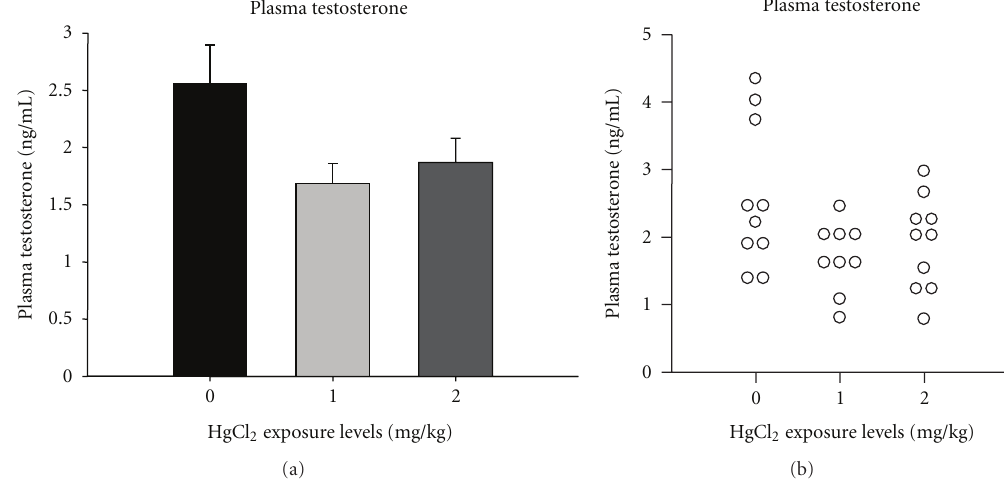
Figure 4: Plasma testosterone levels (a) levels of blood plasma testosterone (ng/g) for each exposure group. (b) Distribution of blood plasma testosterone for each exposure group. Data are mean and SE. No significant di ff erence was found between groups.